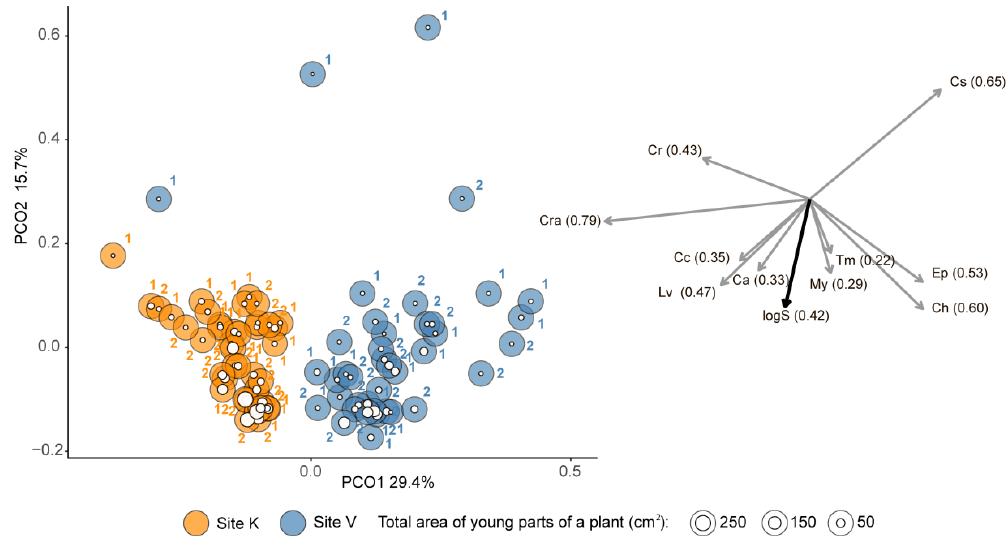
Figure 5. Principal coordinates ordination (PCO) of sessile species percent covers on young parts of Phycodrys rubens in September 2015. Bray-Curtis similarity on fourth root transformed data. Labels (1 or 2) indicate the replicate frame number. Species with R 2 (in brackets) > 0.2: My—juvenile Mytilidae ( Musculus discors and Modiolus modiolus ) (Bivalvia); Cc— Callopora craticula (Bryozoa), Ch— Celleporella hyalina (Bryozoa), Cr—Crisiidae ( Crisia eburnea and Crisiella producta ) (Bryozoa), Cra— Cribrilina annulata (Bryozoa), Ep— Electra pilosa (Bryozoa), Lv— Lichenopora verrucaria (Bryozoa); Cs— Calycella syringa (Hydrozoa), Tm— Tiaropsis multicirrata (Hydrozoa); Ca— Circeis armoricana (Polychaeta); logS—log-transformed surface area of a young plant part. Four of the five top abundant taxa (hereafter ‘dominants’) on old and young plant parts in Table 7. Effects of plant part size (surface Area of the corresponding part, cm 2 ) and location (Sites K September 2015 were common: Circeis armoricana , Cribrilina annulata , Electra pilosa and sponges. While or V) on the multivariate community structure of epibiosis on young and old plant parts of Phycodrys Celleporella hyalina was the fifth one on young parts, old blades were co-dominated by juvenile rubens in September 2015: type III sum of squares PERMANOVA for 9999 permutations on fourth root transformed covers of sessile epibionts, Bray-Curtis similarity, frames pooled. Significant terms are highlighted in bold. Source of Unique Age df SS MS pseudo-F p Variation Permutations Area 1 5498 Young parts Area 1 Old parts